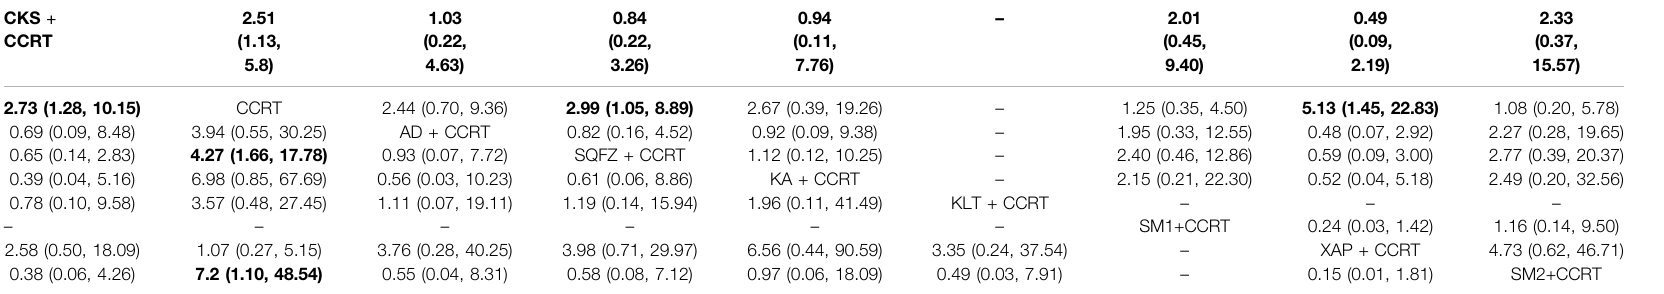
TABLE 5 | Results of the NMA of nausea and vomiting (upper-right quarter) and grade ≥ 3 oral mucositis (lower-left